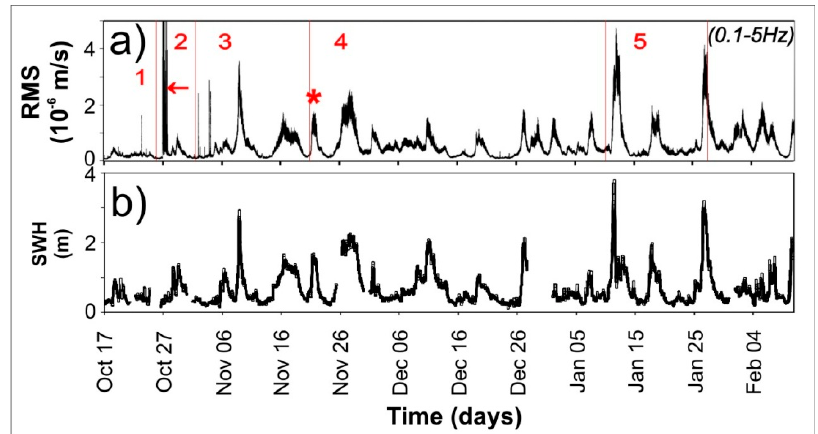
Figure 2. Comparison between ( a ) RMS of background seismic signal (filtered in the range of 0.1 to 5 Hz) and ( b ) significant Sea Wave Height (SWH). Red vertical bars and numbers refer to the period of volcanic activity described in Table 1; the red arrow indicates the 2002–2003 eruption onset; the red asterisk marks the episode of oceanographic noise increase analysed in Figure 4b.